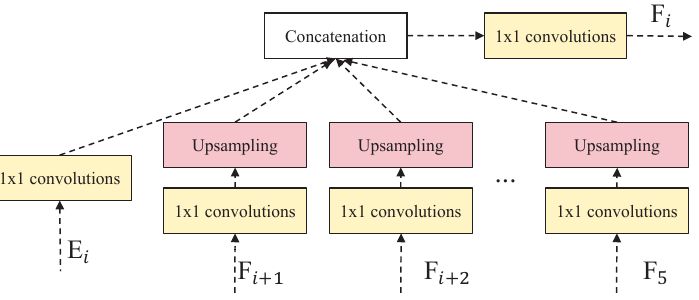
Figure 5. The feature fusion module (FFM) is used to concatenate same-scale feature map in top-down branch and all larger-scale feature maps in bottom-up branches.